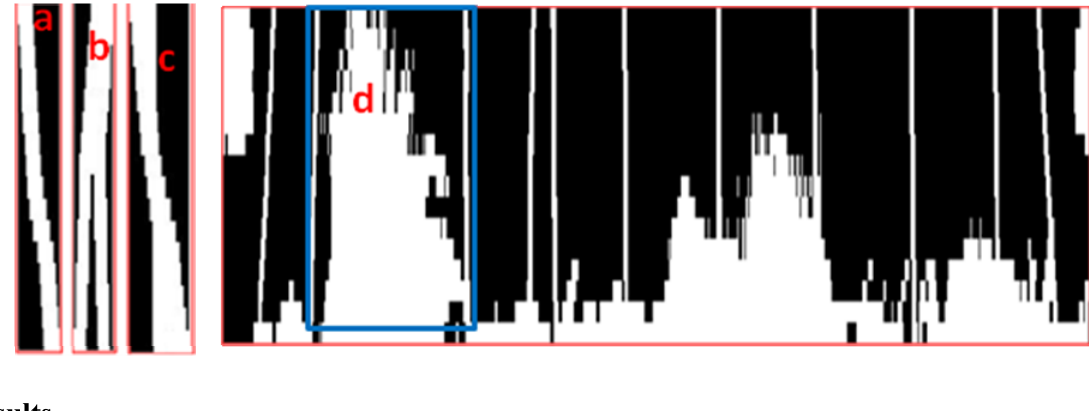
Figure 10. Examples of segmented sub-matrixes: ( a ) one hanger, ( b ) crossed hangers and ( c ) overlapped hangers. Main image matrix with noise ( d ): The obstacles are too high and are not possible to infer the actual number in the corresponding